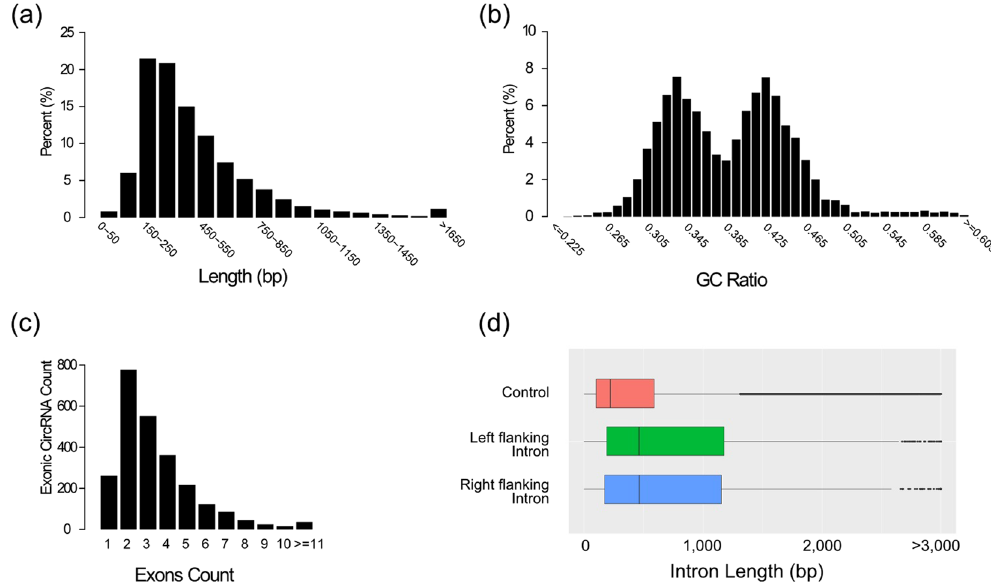
Figure 2. Sequence features of circRNAs in soybean. ( a ) Distribution of length of circRNAs in soybean. ( b ) Distribution of GC ratio of circRNAs in soybean. ( c ) Number of exonic circRNAs that contained different number of exons derived from parental genes in soybean. ( d ) Distribution of length of the flanking introns that bracketing exonic circRNAs in soybean.